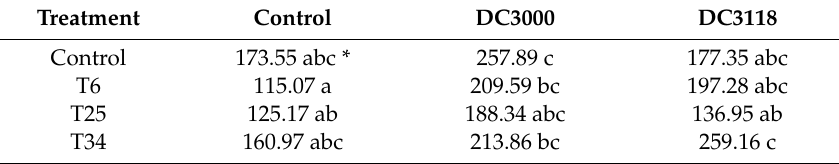
Figure 2. Relative expression of defense-response genes in 4-week-old tomato plants inoculated with P. syringae (Pst ). ( A ) The samples were collected 72 h after mock-inoculated plants (Mock, control plants untreated neither with Trichoderma nor with Pst ) or Pst -inoculated plants (C-DC3000 and C-DC3118) using an MgCl 2 -surfactant solution for 10 s. Four biological replicates per treatment with three technical replicates each were used in the analysis. The data are displayed as the relative quantity (RQ, 2 − ∆∆ Ct ) + standard deviations of target genes compared to those of their basal condition (Mock). The expression values of each gene were normalized to the quantity of the actin gene used as the endogenous gene. ( B , C ) Plot detail with the relative expression of PAL5 and PINII genes, as shown in panel ( A ). The values in each bar followed by a di ff erent letter di ff er significantly (Tukey’s test at p < 0.05) when compared among treatments (Mock, C-DC3000, and C-DC3118) within each gene. Table 3. PAL activity in 4-week-old tomato plants 72 h post- Pseudomonas syringae pv. tomato inoculations (DC3000 and DC3118) under three Trichoderma treatments (T6 = T. parareesei , T25 = T. asperellum , and T34 = T. harzianum